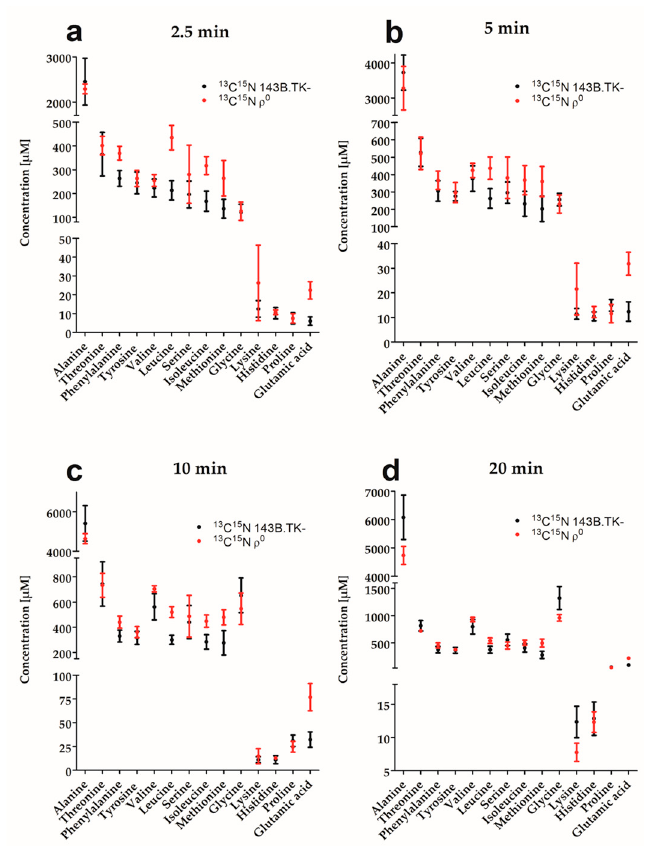
Figure 4. Absolute concentration of labeled amino acids for ρ 0 (red) and 143B.TK- (black) cells after switching the culture medium from unlabeled to labeled amino acids. Concentrations for 13 C 15 N amino acid are shown in µM at time points: ( a ) 2.5 min; ( b ) 5 min; ( c ) 10 min; and ( d ) 20 min. Data were expressed as mean and standard deviation (mean ± SD; n = 6).